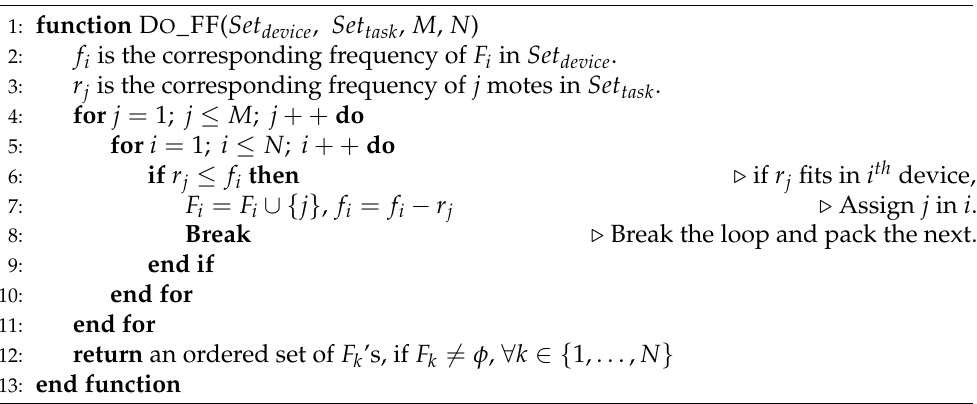
Algorithm 2 First-fit algorithm for the initial packing.